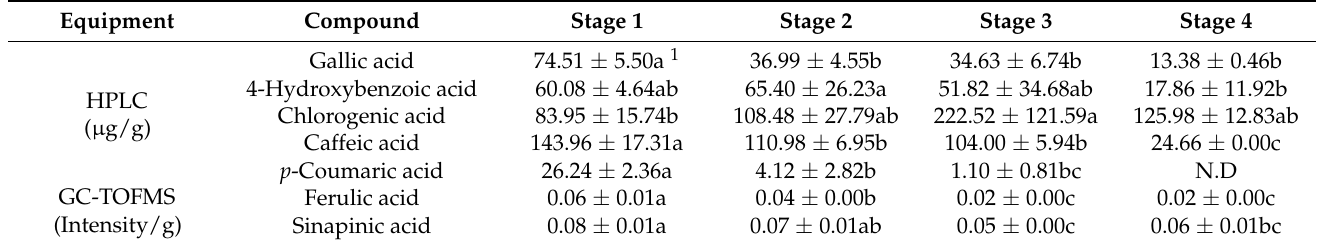
Table 3. HPLC and GC-TOFMS analysis of phenolic acids in the different flowering stages of L . radiata .